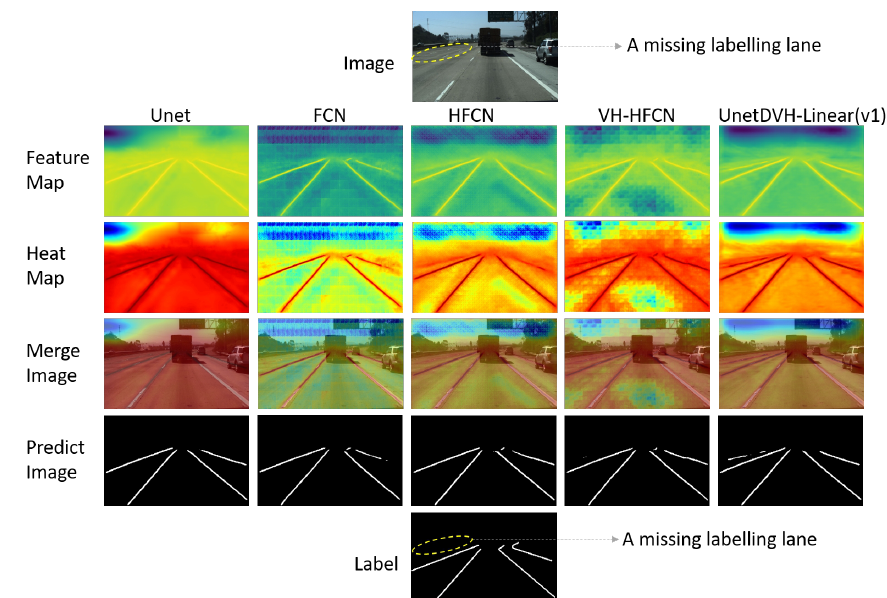
Figure 5. Feature map visualization example of the output layer with different models. There is a missing labeling lane in the label image.